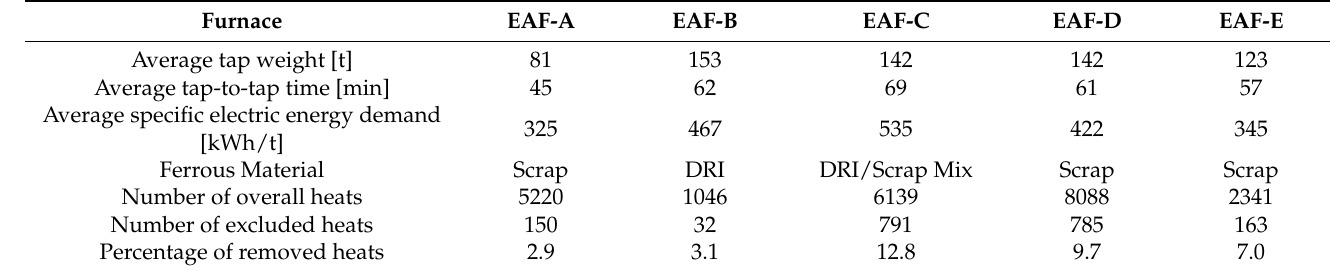
Table 2. Specification and key performance indicators of the investigated electric arc